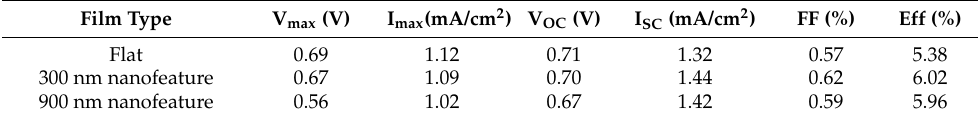
Figure 14. Current–voltage profiles of the solar cell with and without nanofeatured films. Table 4. Current-voltage characteristics of the solar cells subjected to polymer films with and without